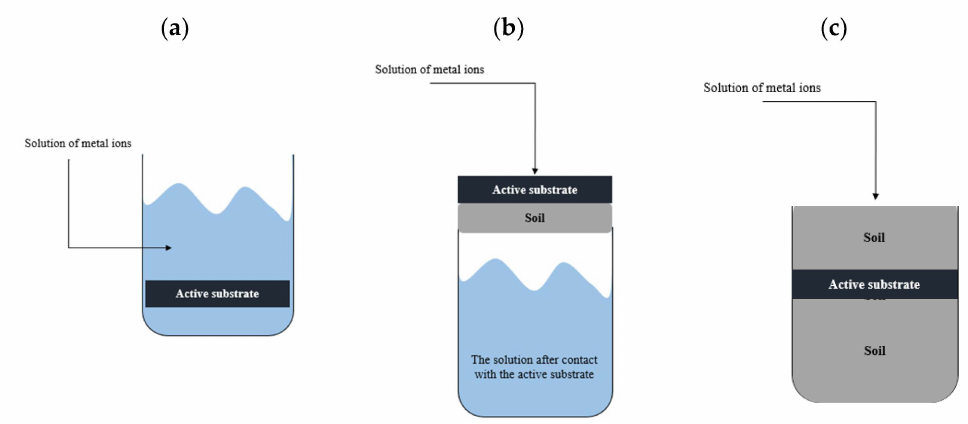
Figure 6. Graphical presentation of the sorption processes: ( a ) Experiment 1, ( b ) Experiment 2, and ( c ) Experiments 3, 4, and